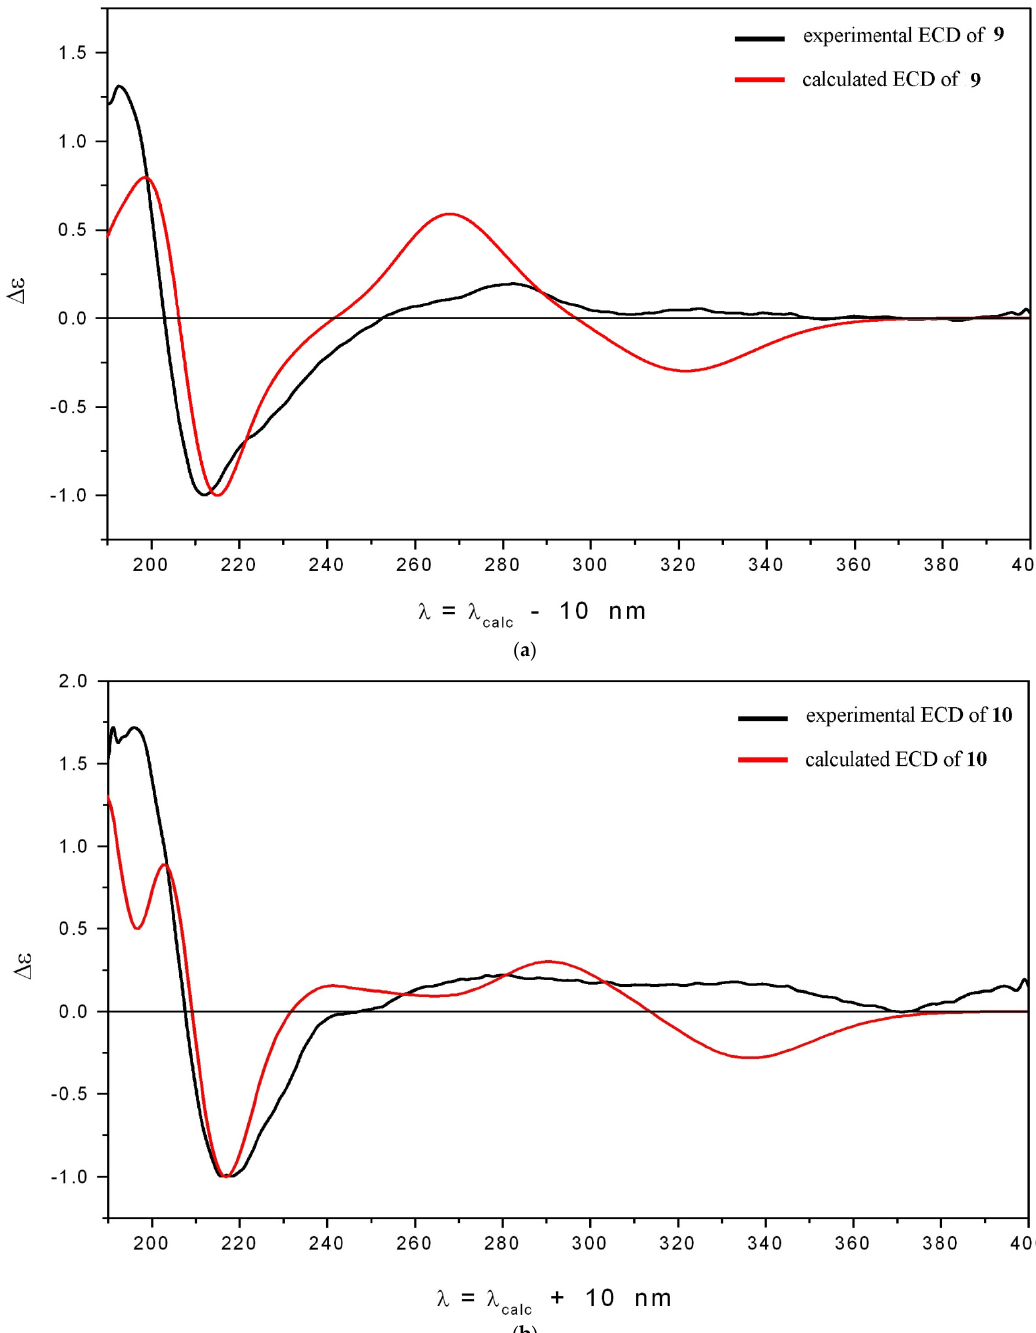
Figure 2. Experimental and calculated ECD spectra for compounds 9 ( a ) and 10 ( b ).